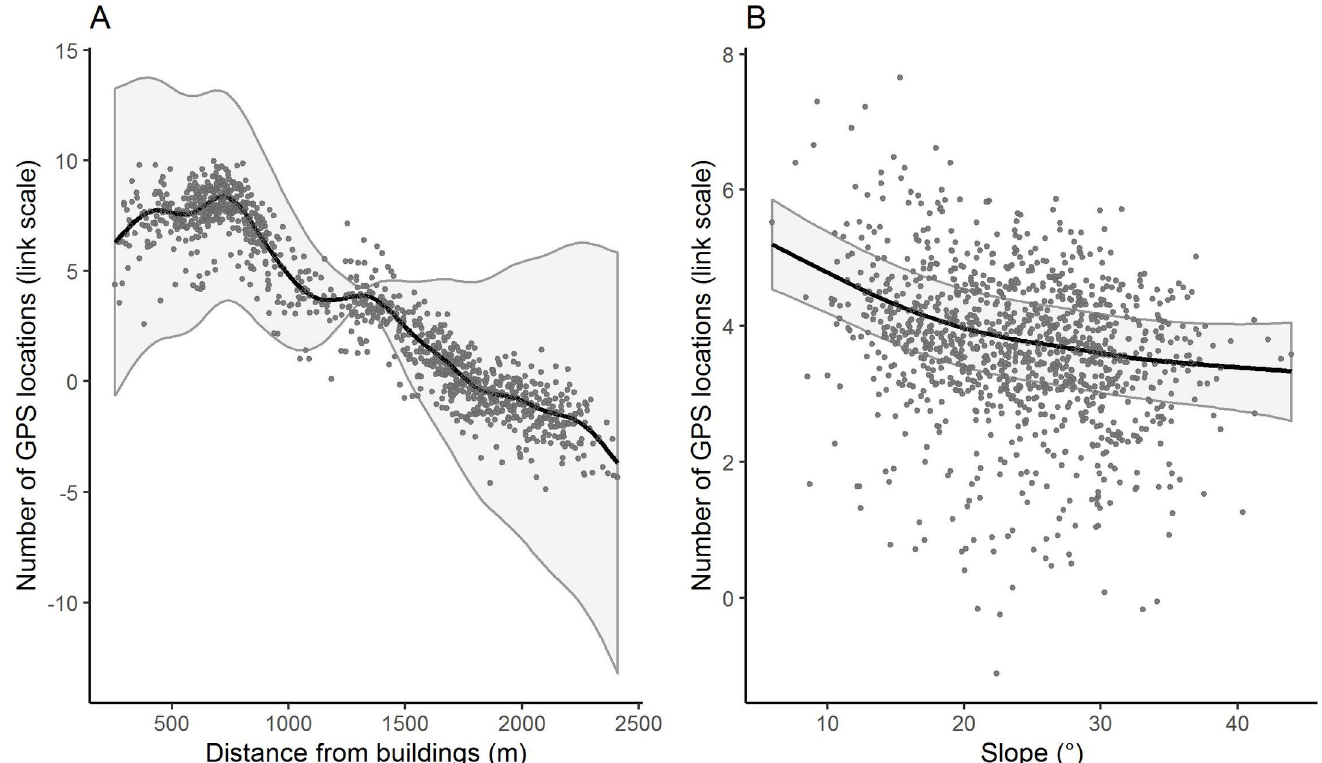
Fig 3. Estimated smoothing curves for the distance from buildings (A) and the slope (B) from the Generalized Additive Model (GAM). The response variable is the number of GPS locations in the link scale unit of the GAM.